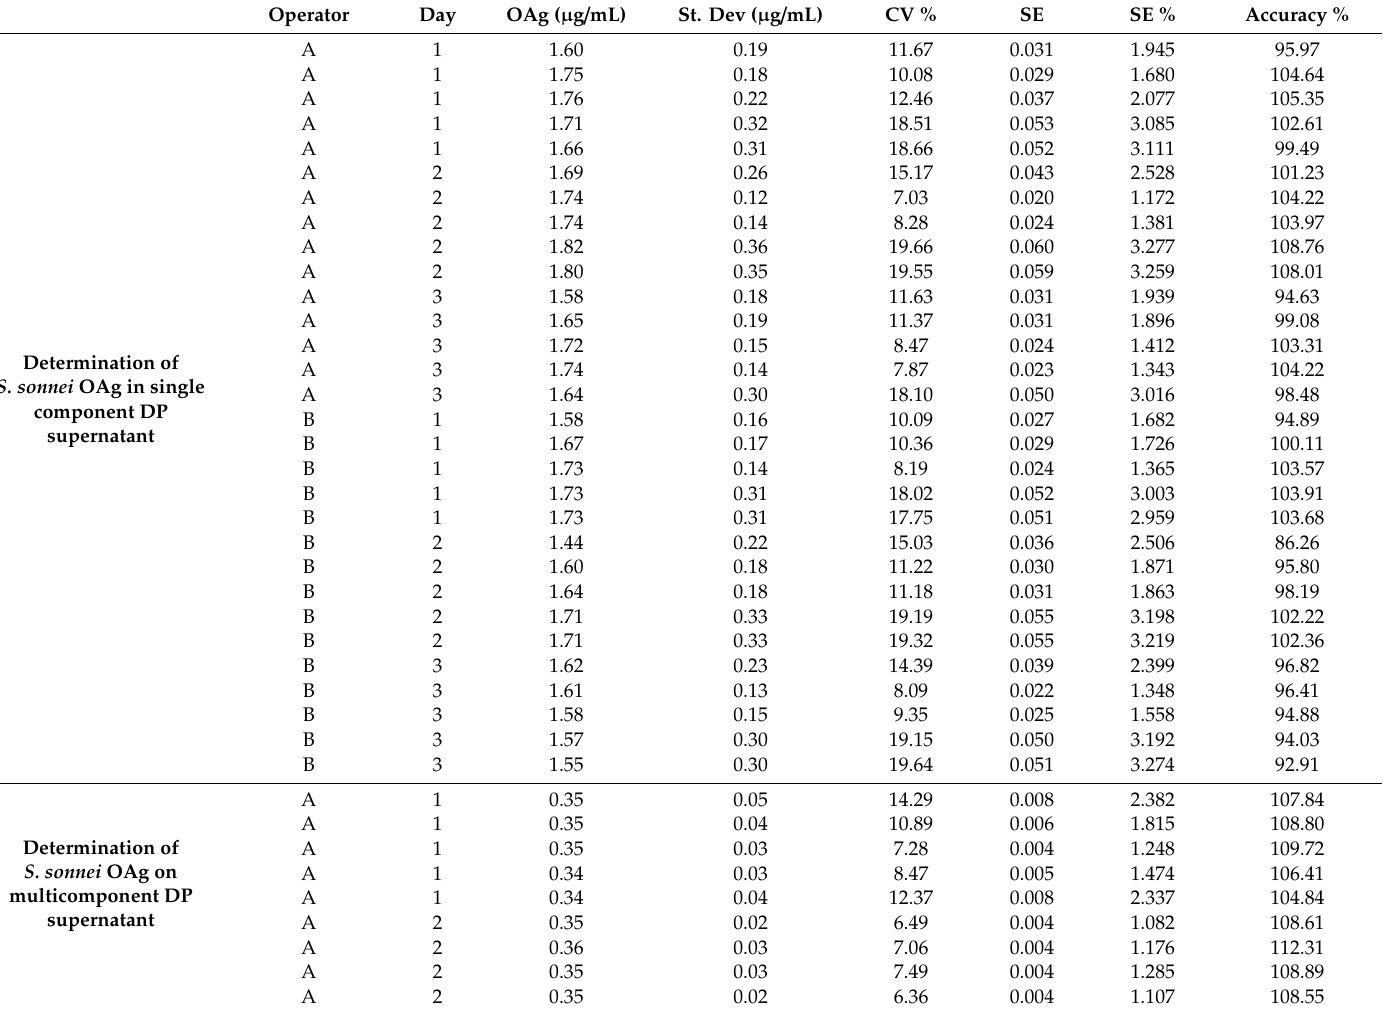
Table 2. cELISA results for each single test performed. n.d., not detectable; St. Dev, standard deviation; SE, standard error; CV, coe ffi cient of